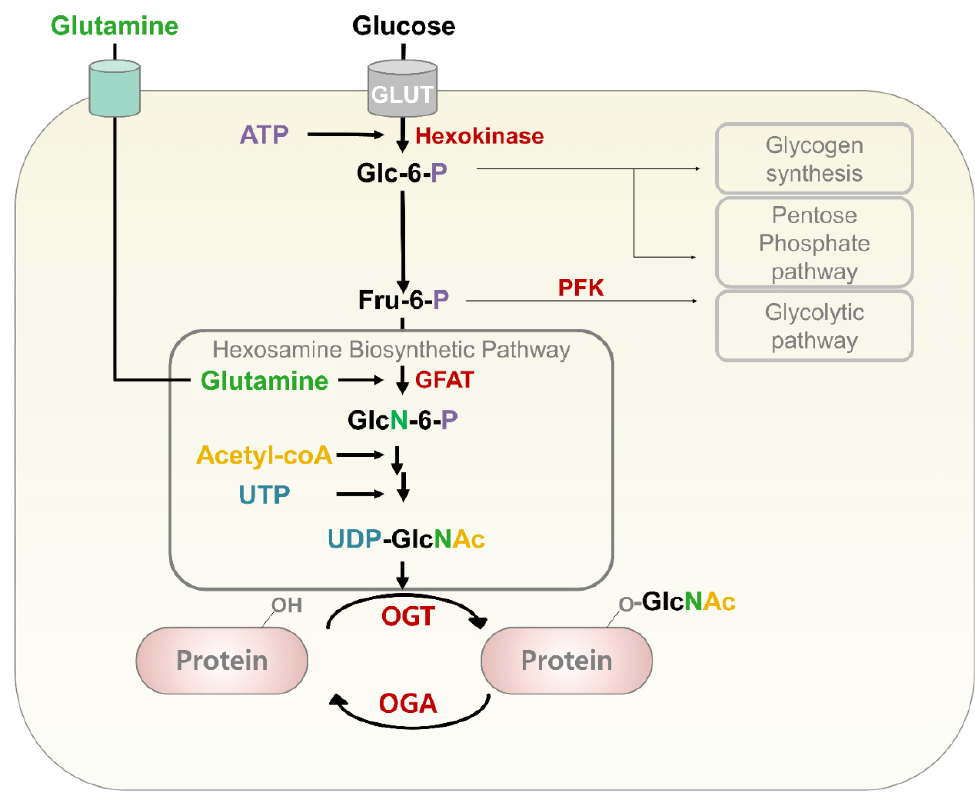
Figure 2. UDP-GlcNAc synthesis via the HBP and O -GlcNAc cycling. In the HBP, UDP-GlcNAc, an active monosaccharide donor for O -GlcNAcylation, is synthesized by consolidating glucose, glutamine, acetyl-CoA, and UTP, which are metabolites of carbohydrates, proteins, lipid acids, and nucleotides, respectively. The GlcNAc moiety of UDP-GlcNAc is transferred by OGT to the hydroxyl group of Ser/Thr residues on target proteins. O -GlcNAc from target proteins is then hydrolyzed by OGA.